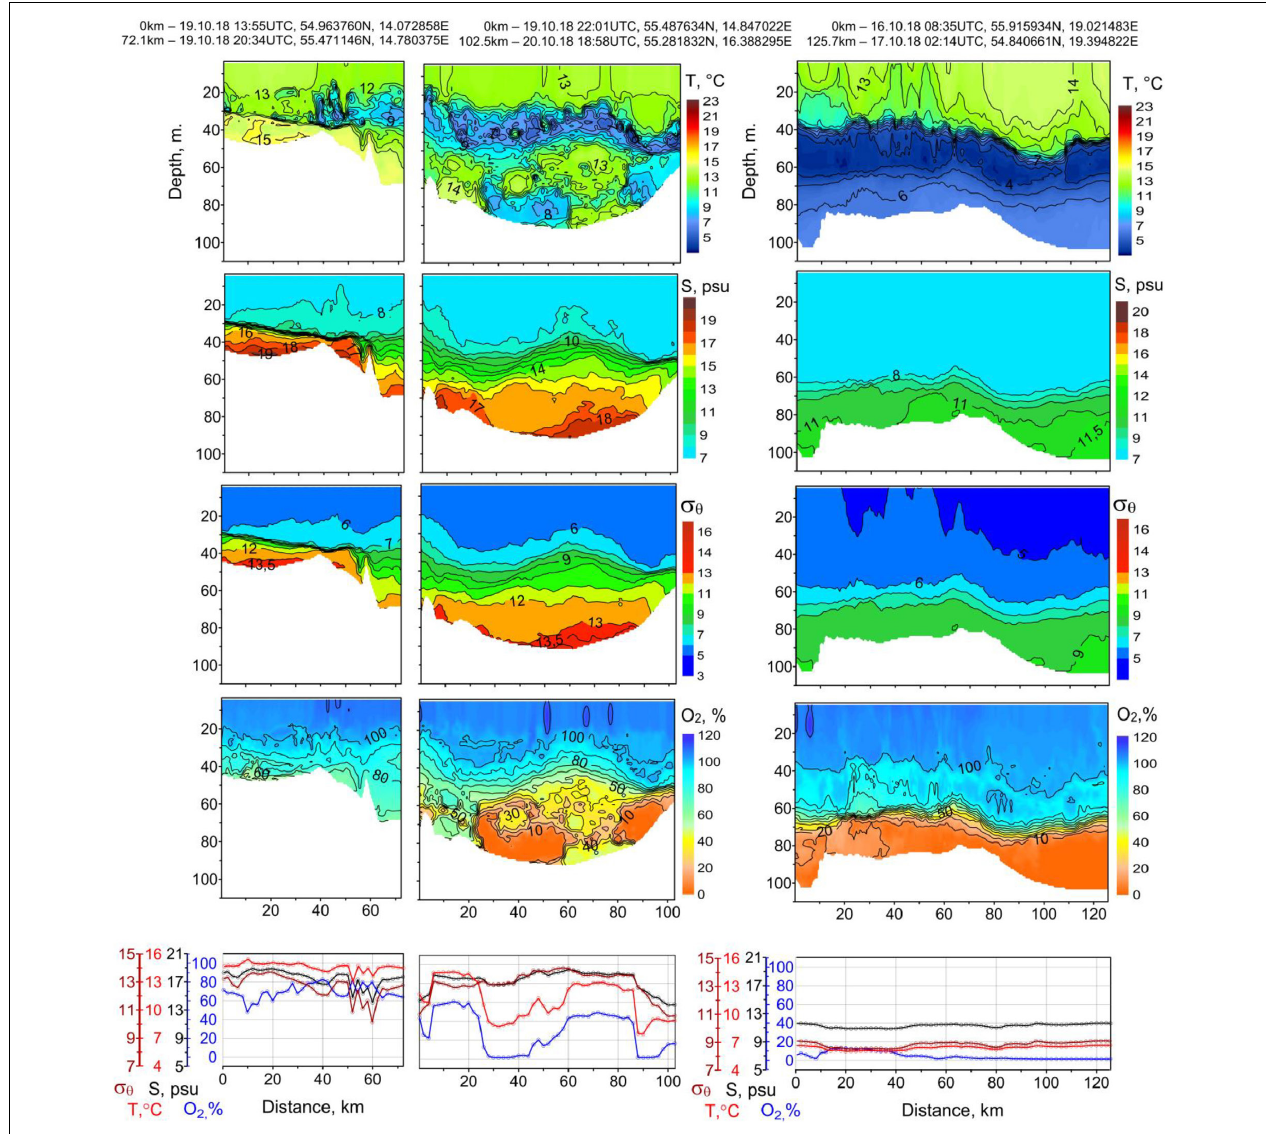
FIGURE 9 | Distributions of temperature T ( ◦ C), salinity S (psu), density σ θ , and oxygen saturation O 2 (%) in the southern Baltic for the 4th survey (October 2018); bottom panels demonstrate graphs of the same parameters in the bottom